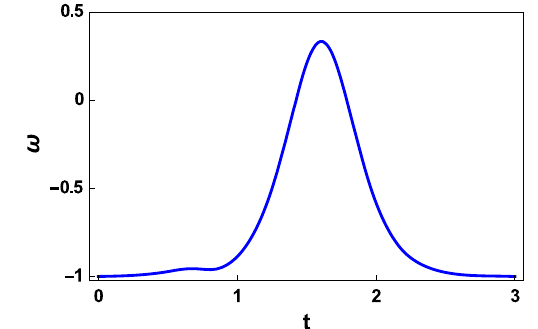
Fig. 3 Time evolution of the analytical EoS parameter derived from a three-field